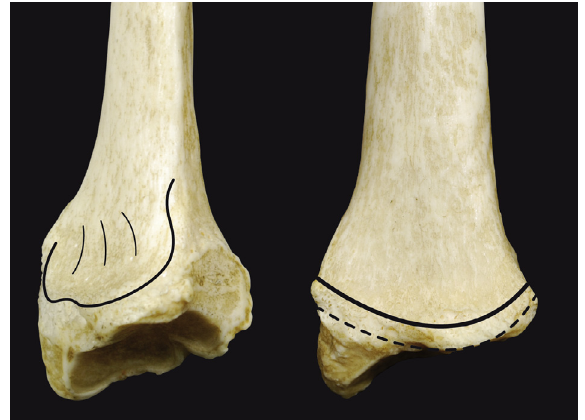
Figure 3. One oblique and one anterior view of the distal radius showing the more proximal pronator quadratus line (solid line) and the watershed line (dashed line).